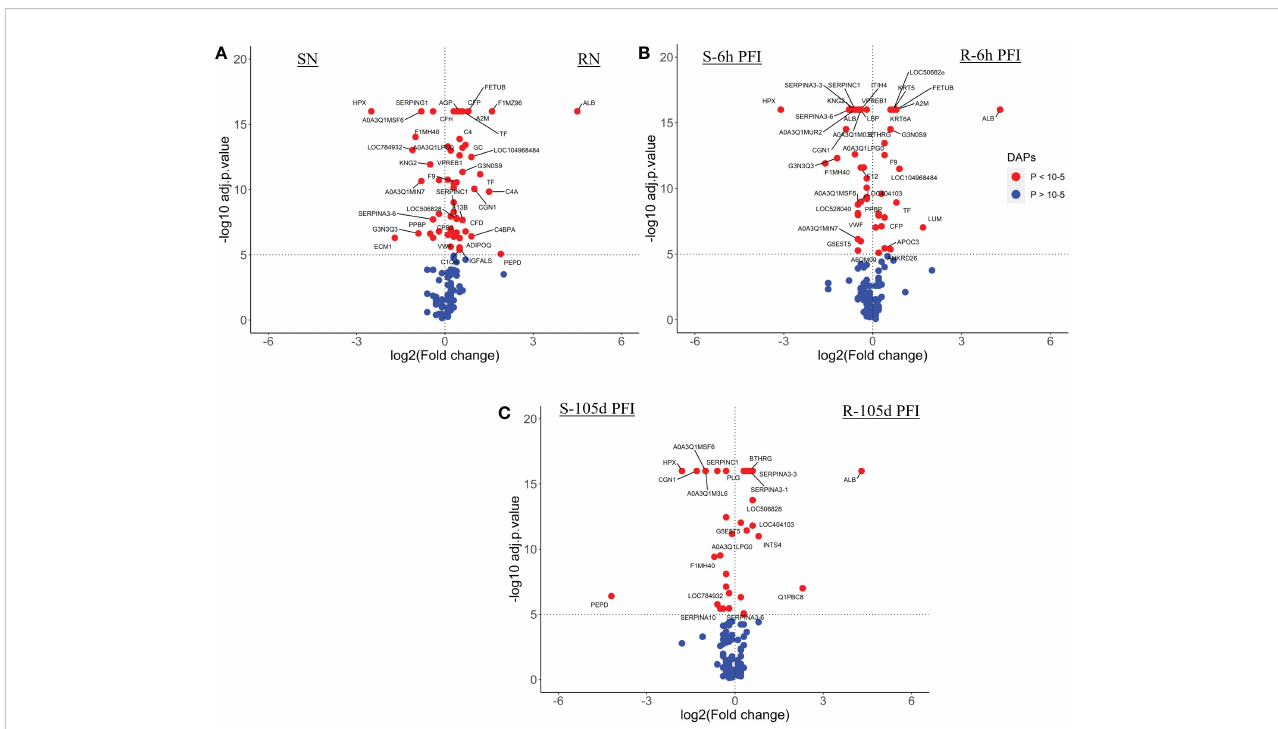
FIGURE 8 Volcano plots illustrating the DA proteins in serum samples of tick-resistant and -susceptible groups of cattle when compared before and after exposure to cattle ticks. DA proteins in (A) susceptible naïve compared to resistant naïve (SN vs RN) samples; susceptible compared to resistant cattle following (B) early (S-6h PFI vs R-6h PFI) and (C) prolonged S-105d PFI vs R-105d PFI tick infestation. Coloured dots represent proteins signi fi cantly different in abundance (P < 10 -5 ). Red, signi fi cantly different in abundance (P < 10 -5 ). Blue, not signi fi cantly different in abundance (P > 10 -5